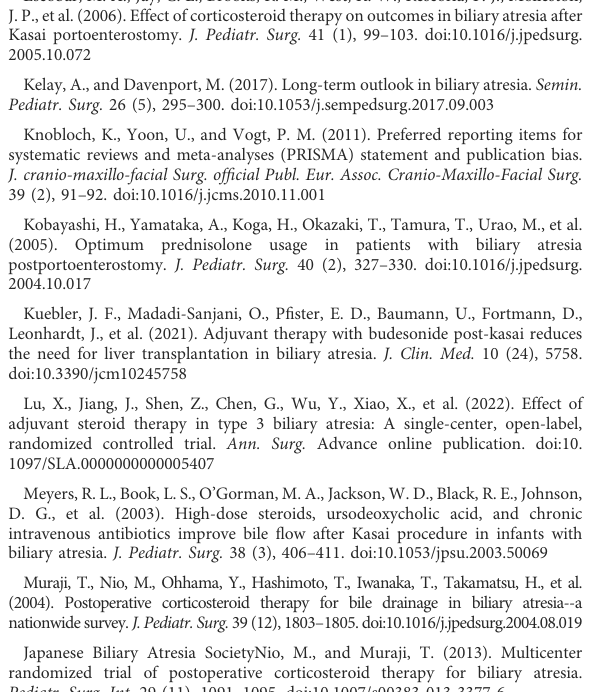
SUPPLEMENTARY FIGURE S1 The result of sensitivity analysis regarding JCR at 12 months. SUPPLEMENTARY FIGURE S2 The result of sensitivity analysis regarding JCR at 24 months. SUPPLEMENTARY FIGURE S3 The result of sensitivity analysis regarding NLSR at 6 months. SUPPLEMENTARY FIGURE S4 The result of sensitivity analysis regarding NLSR at 12 months. SUPPLEMENTARY FIGURE S5 The result of sensitivity analysis regarding NLSR at 24 months. SUPPLEMENTARY FIGURE S6 The result of sensitivity analysis regarding postoperative